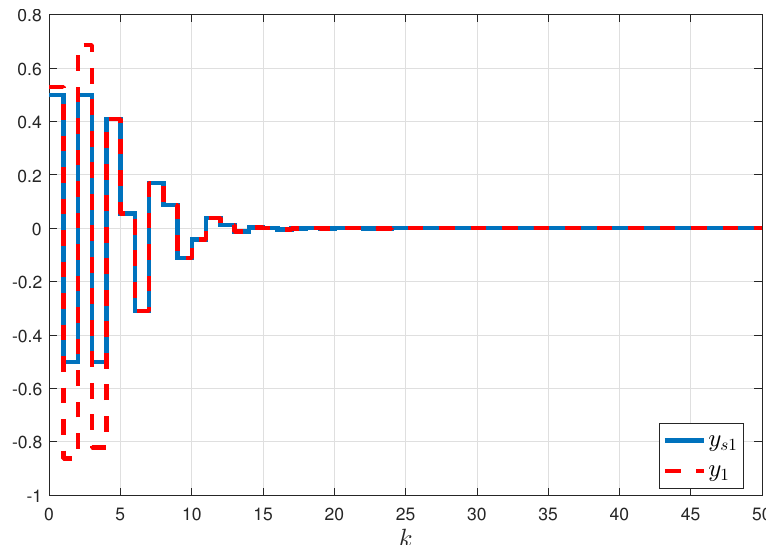
Figure 1. Actual and ideal measurements of y 1 .